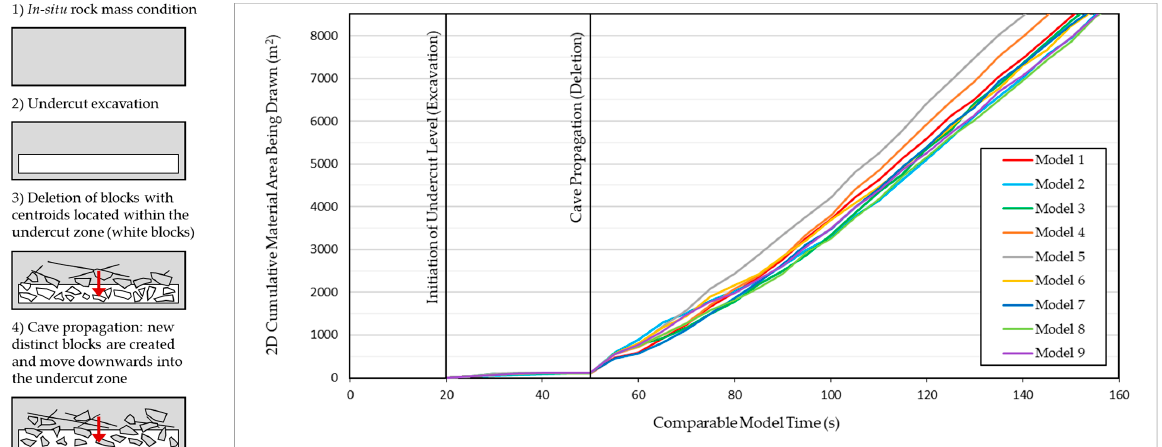
Figure 12. ELFEN deletion methodology and model production over time. Model time is